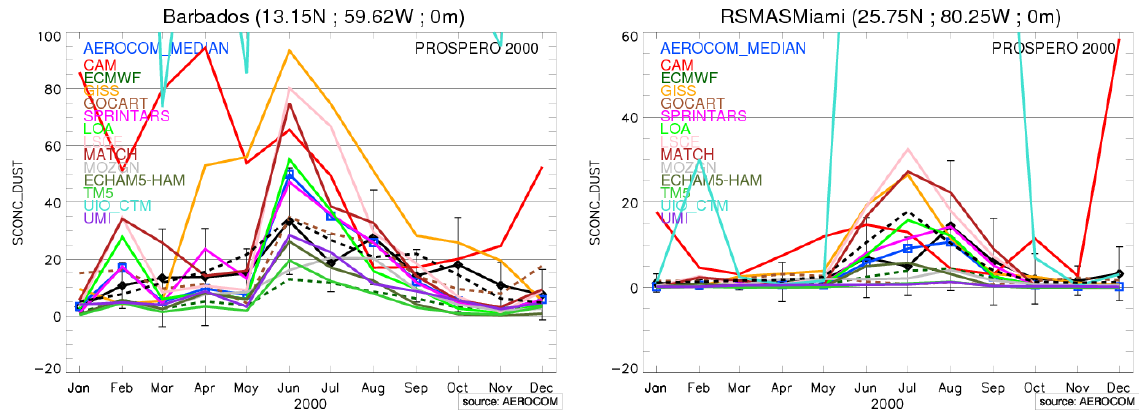
Fig. 7. Measured and simulated surface concentration in Barbados and Miami. Measurements of the year 2000 are presented by the black continuous line and the climatology (Fig. 6) is presented by the black dashed line. Units are µgm − 3 .